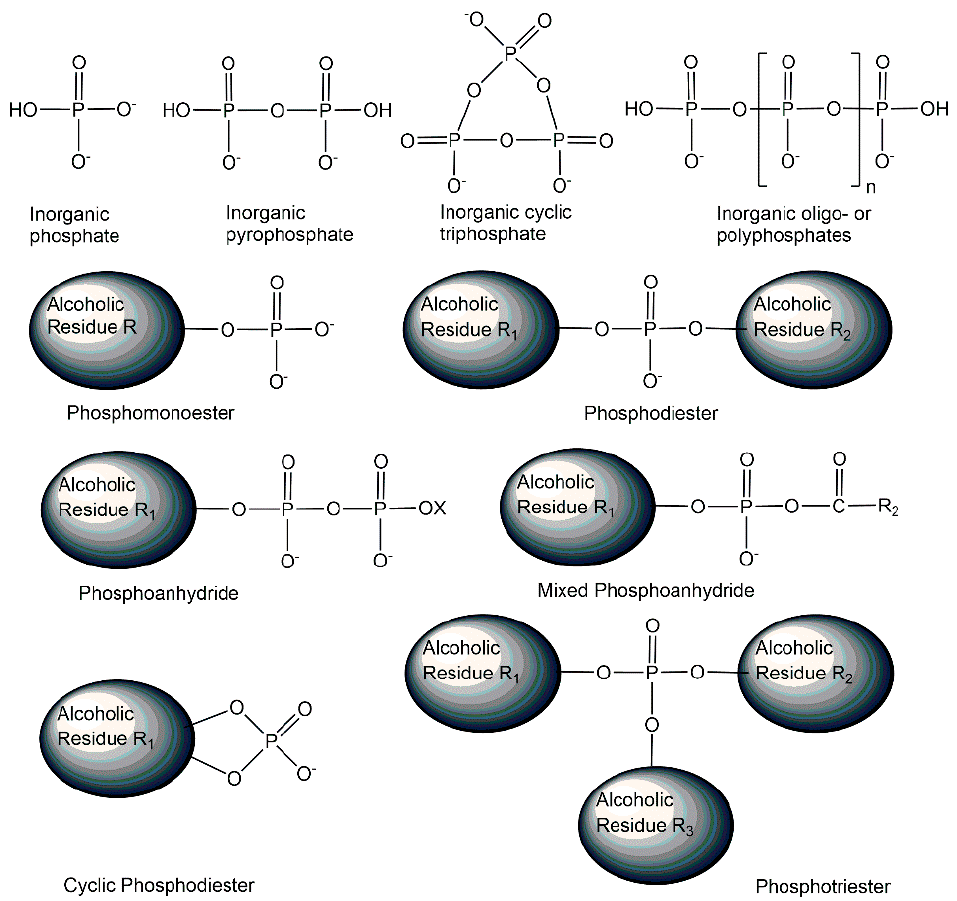
Figure 1. Selected phosphometabolite structures containing pentavalent phosphorus in oxidation state +5 and covalent phosphorus-oxygen bonds.